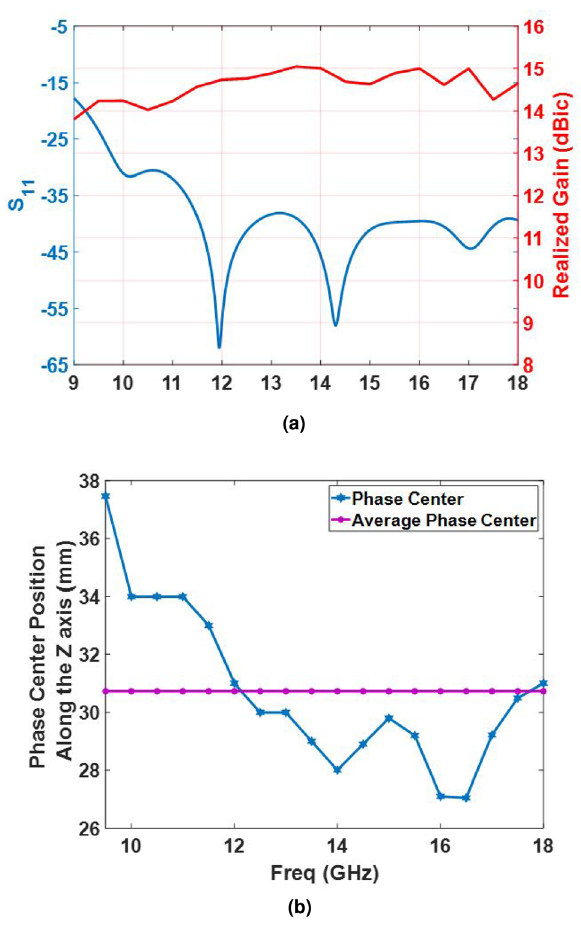
Figure 9. ( a ) Realized gain along with the S 11 parameter of the horn antenna. ( b ) Phase center variations versus frequency and its average. (The S 11 parameter is shown in dB